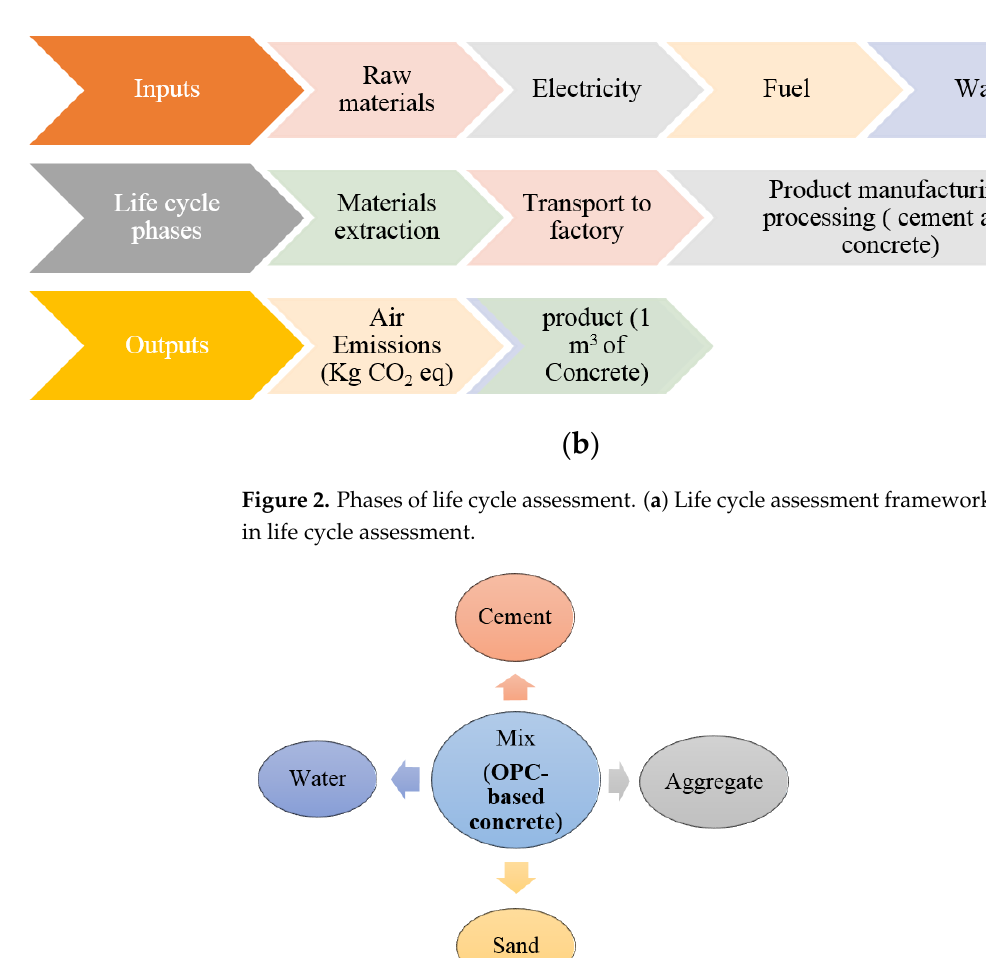
Figure 3. Schematic representation of the ingredients of OPC concrete.